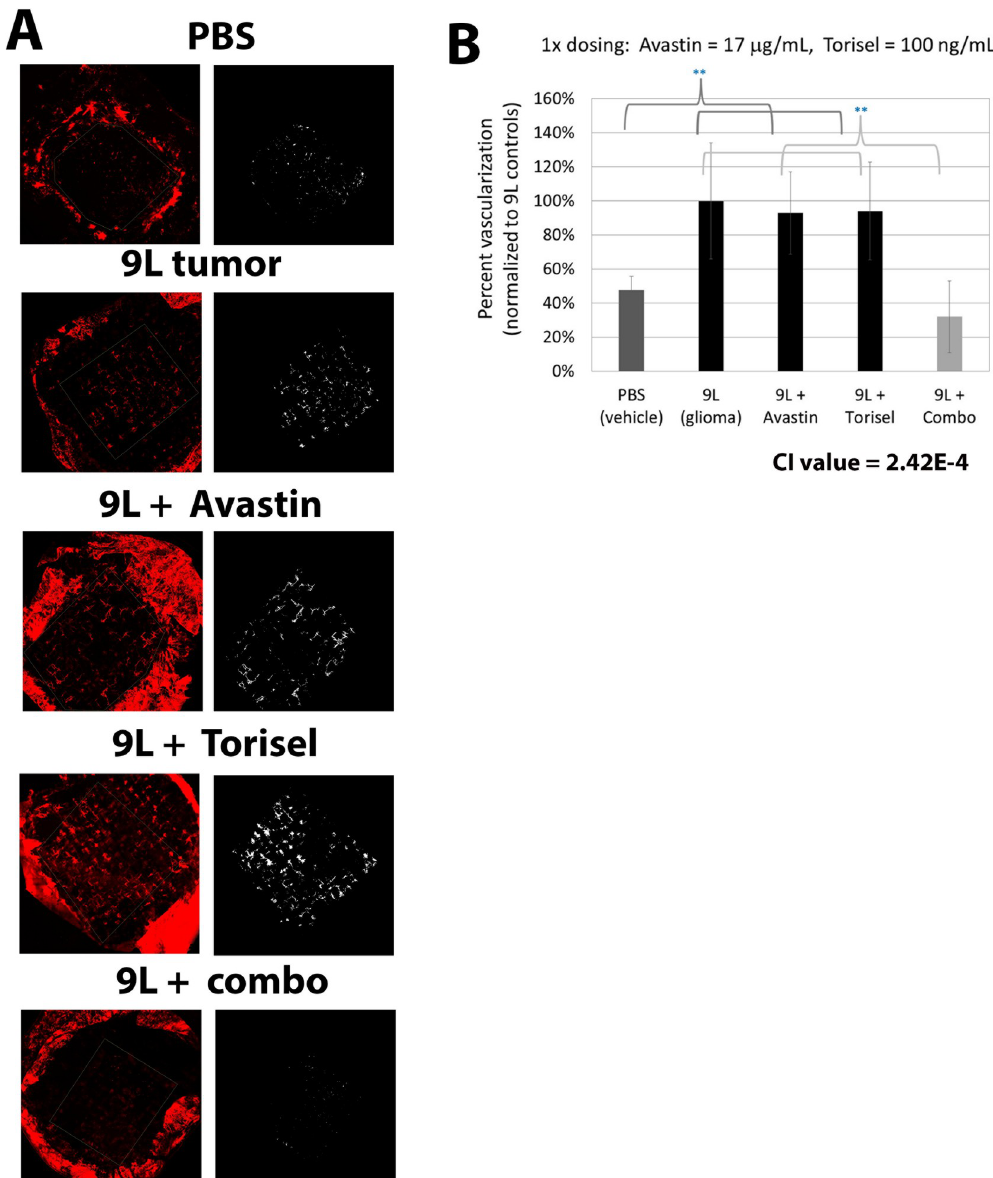
Fig 4. Combining bevacizumab (Avastin 1 ) and temsirolimus (Torisel 1 ) results in significant activity blocking tumor- induced NV. (A) Representative images of the tumor onplants from the different treatment groups are shown with the original image on the left and the image showing the results of quantification on the right, followed by quantification of tumor NV (B). As expected, Avastin 1 and Torisel 1 did not demonstrate significant reduction in tumor NV individually using the maximum doses of no effect found in the earlier dosing studies (Fig 3). However, significant reduction in tumor- induced angiogenesis was observed when combining Avastin 1 and Torisel 1 at these same doses. The resulting angiogenesis levels are comparable to the no-tumor negative control levels. X-axis groups indicate what was included in the collagen onplant. Data include results from six separate experiments with over thirty individual onplants per group per each experiment. Error bars represent standard deviation. �� indicates p values < 0.01 between the indicated groups. The calculated CI value indicates a synergistic effect when combination compared to each